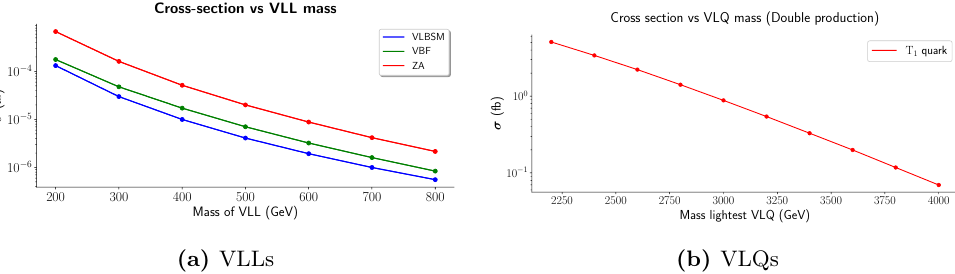
Figure 7. The production cross-section as a function of the VLLs mass (left panel) and the VLQ mass (right